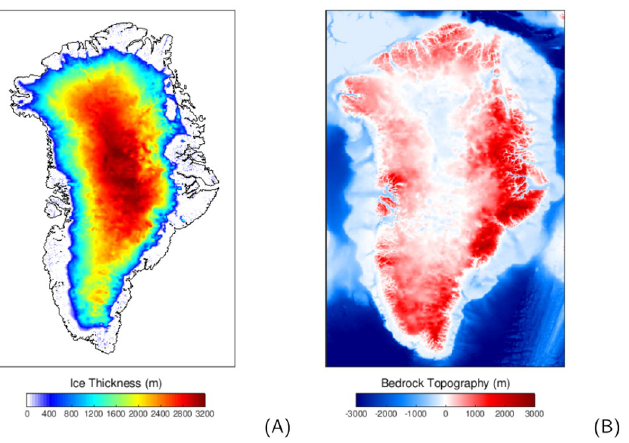
Fig 1. The model domain of the ice sheet model. The model domain of the ice sheet model. The left subpanel shows the ice thickness used to initialise the model (shading) and the contemporary coast line (black contour line) while the right subpanel depicts the corresponding bedrock topography. These data are derived from the ETOPO1 data set